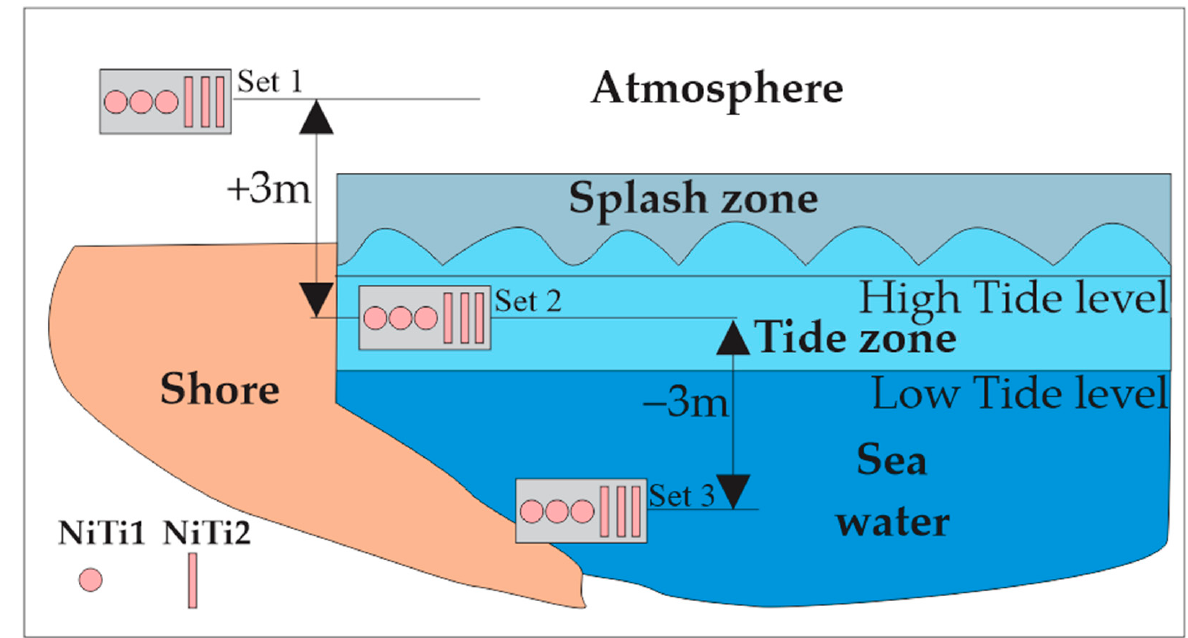
Figure 2. Graphical representation of the NiTi alloys’ conceptual research model. Table 1. Chemical composition of the NiTi1 and NiTi2